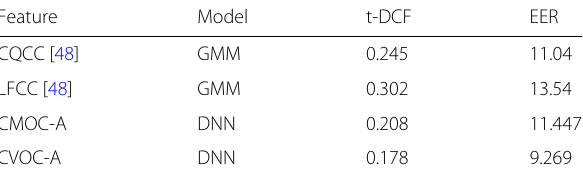
Table 15 Comparison with some known systems on ASVspoof 2019 physical access evaluation set in terms of t-DCF and EER (%) Feature Model t-DCF EER CQCC [48] GMM 0.245 11.04 LFCC [48] GMM 0.302 13.54 CMOC-A DNN 0.208 11.447 CVOC-A DNN 0.178